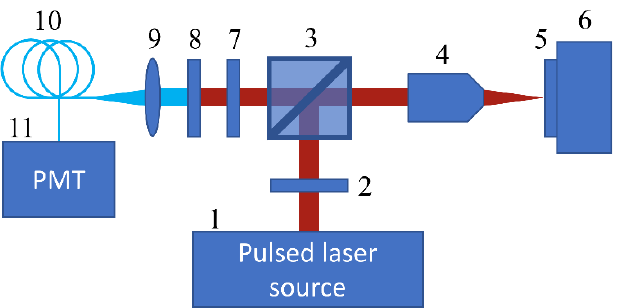
Figure 1. Scheme of experimental setup. 1 — laser source, 2 — half-wave plate, 3 — beam splitter, 4 — objective lens, 5 — sample, 6 — scanning stage, 7 — polaroid (analyzer), 8 — color filters, 9 — lens, 10 — optical fiber, 11 — photomultiplier tube.